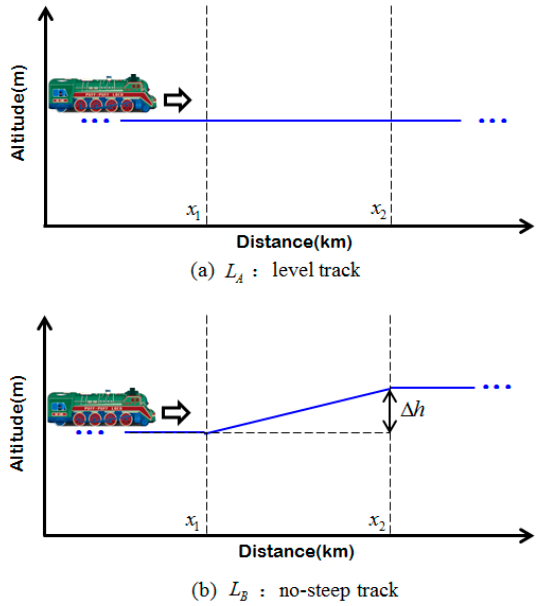
Figure 4. Train travelling on non ‐ steep track compared with level track.